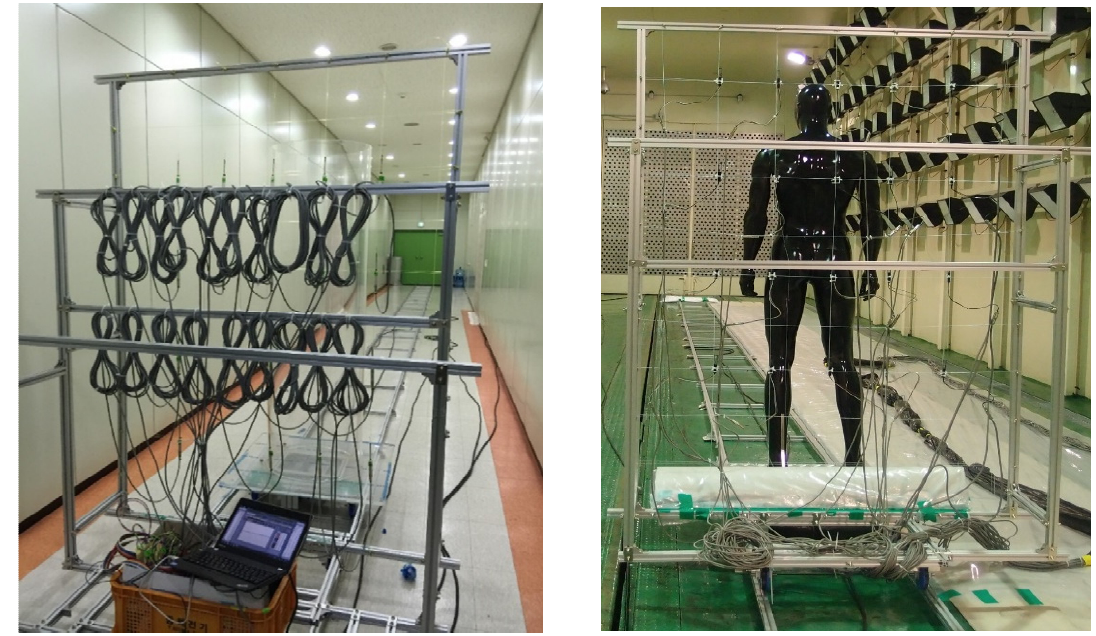
Figure 1. Testbed and sensor support.